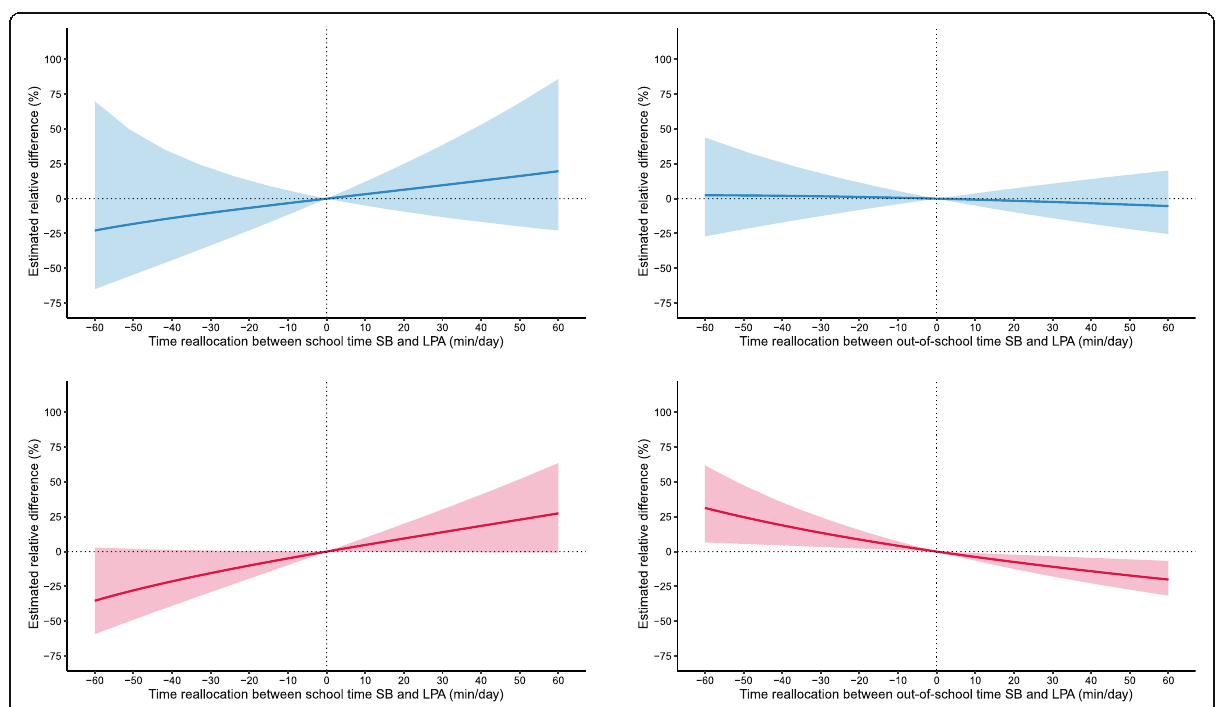
Fig. 1 Relative difference in fat mass percentage associated with replacing school (left) and out-of-school (right) SB with LPA in boys (top) and girls (bottom). Positive values on x -axis present time replacement from context-specific SB to LPA, and negative values time replacement from context-specific LPA to